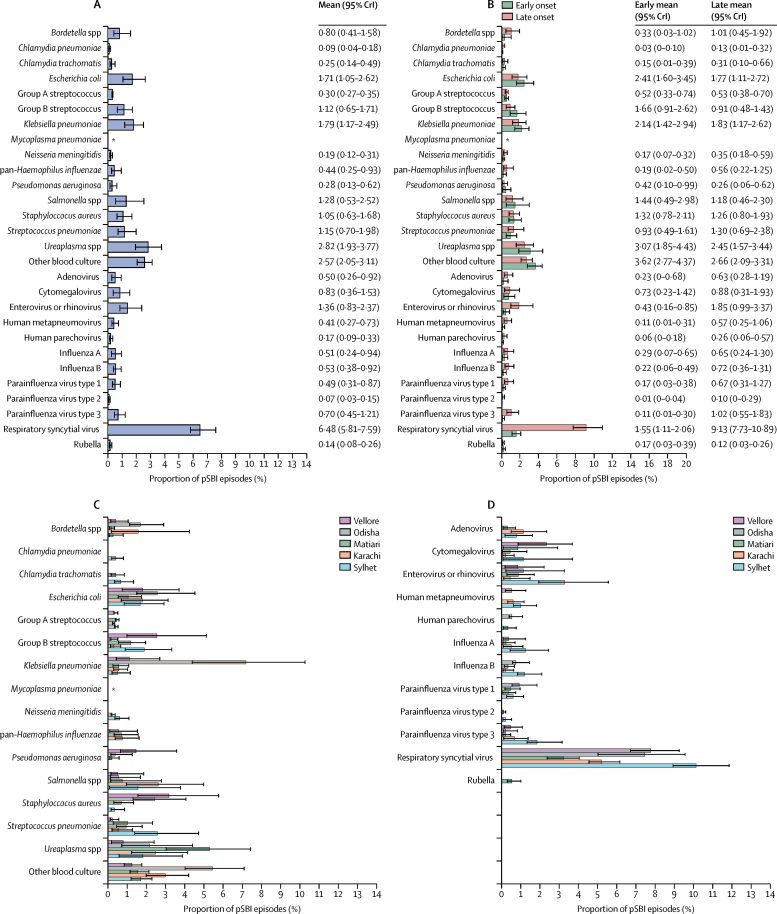
Attributed proportions of causal pathogens tested during possible serious bacterial infection episodes, estimated in a partially latent class model(A) Estimates from overall model. (B) Estimates by age of onset. (C) Estimates of bacterial causes by study site. (D) Estimates of viral causes by study site. CrI=credible interval. pSBI=possible serious bacterial infection. *None detected.